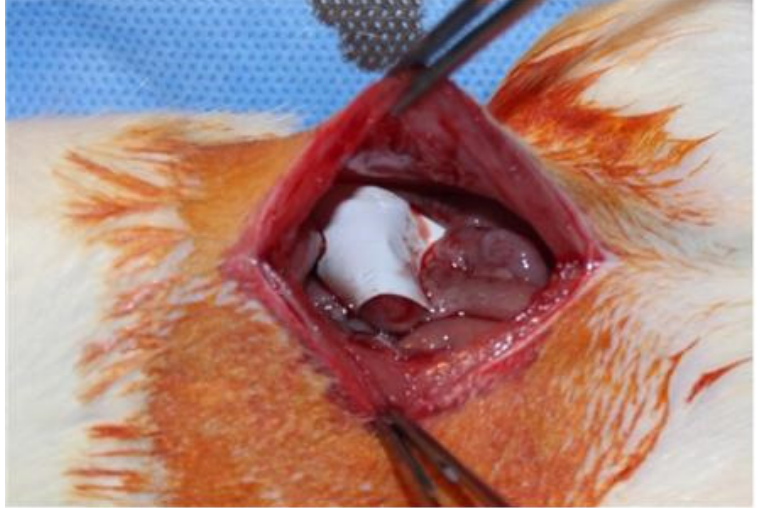
Figure 2. Application of a porous polylactide film (20 mm × 20 mm) to the injured cecum.